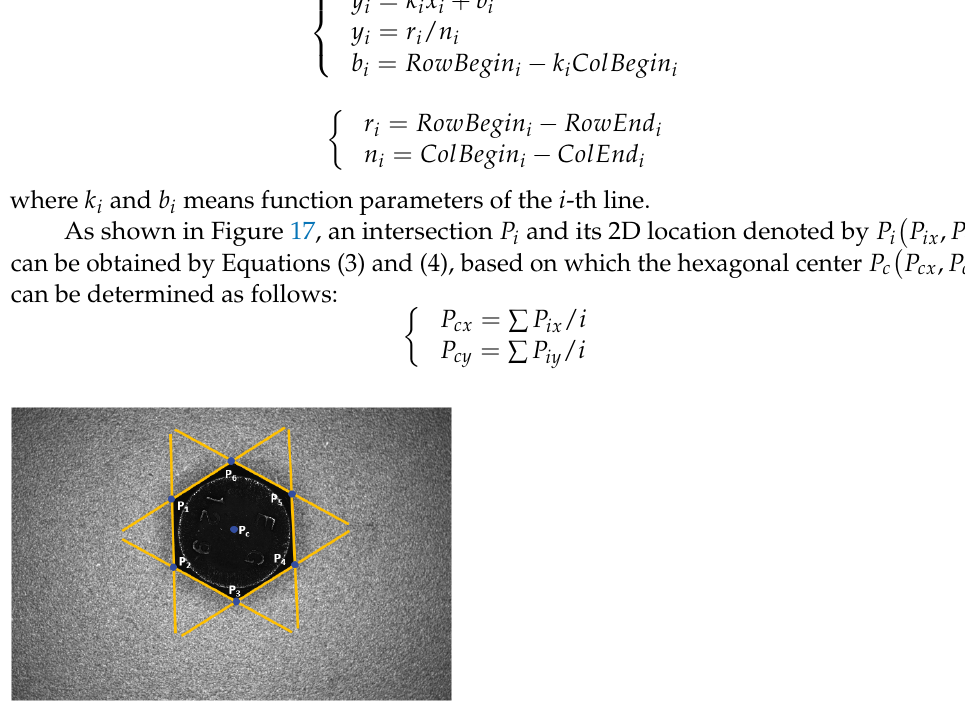
Figure 17. Lines, intersections, and center point used to describe the screw head.